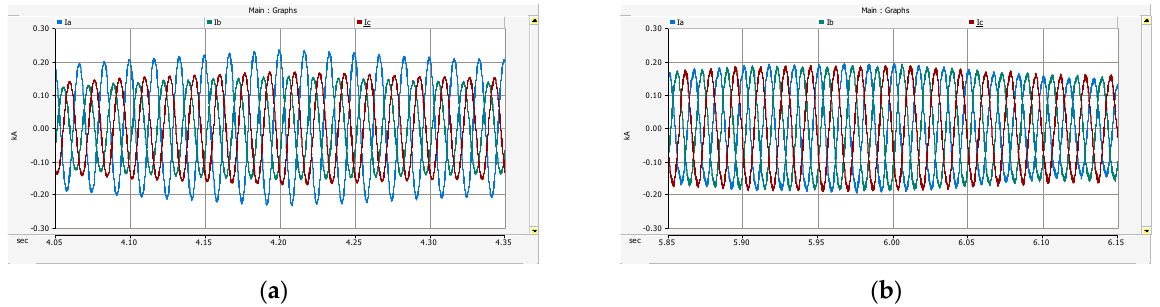
Figure 16. Simulation results of Scenario 2 ( a ) instantaneous three-phase current of the mBESS before dual current control (DCC) and ( b ) instantaneous three-phase current of the mBESS after DCC.